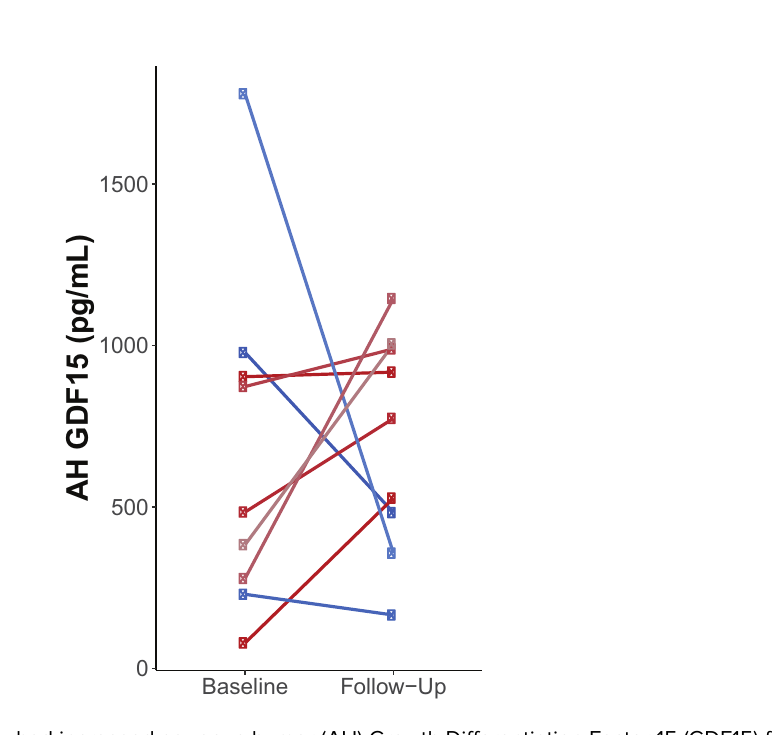
Figure 1. Of the nine participants, six had increased aqueous humor (AH) Growth Differentiation Factor 15 (GDF15) from baseline to follow-up at approximately six months (shades of red), while three had decreased AH GDF15 (shades of blue). Circles denote patients who received the Ahmed® glaucoma valve; squares denote patients who received the Molteno® glaucoma